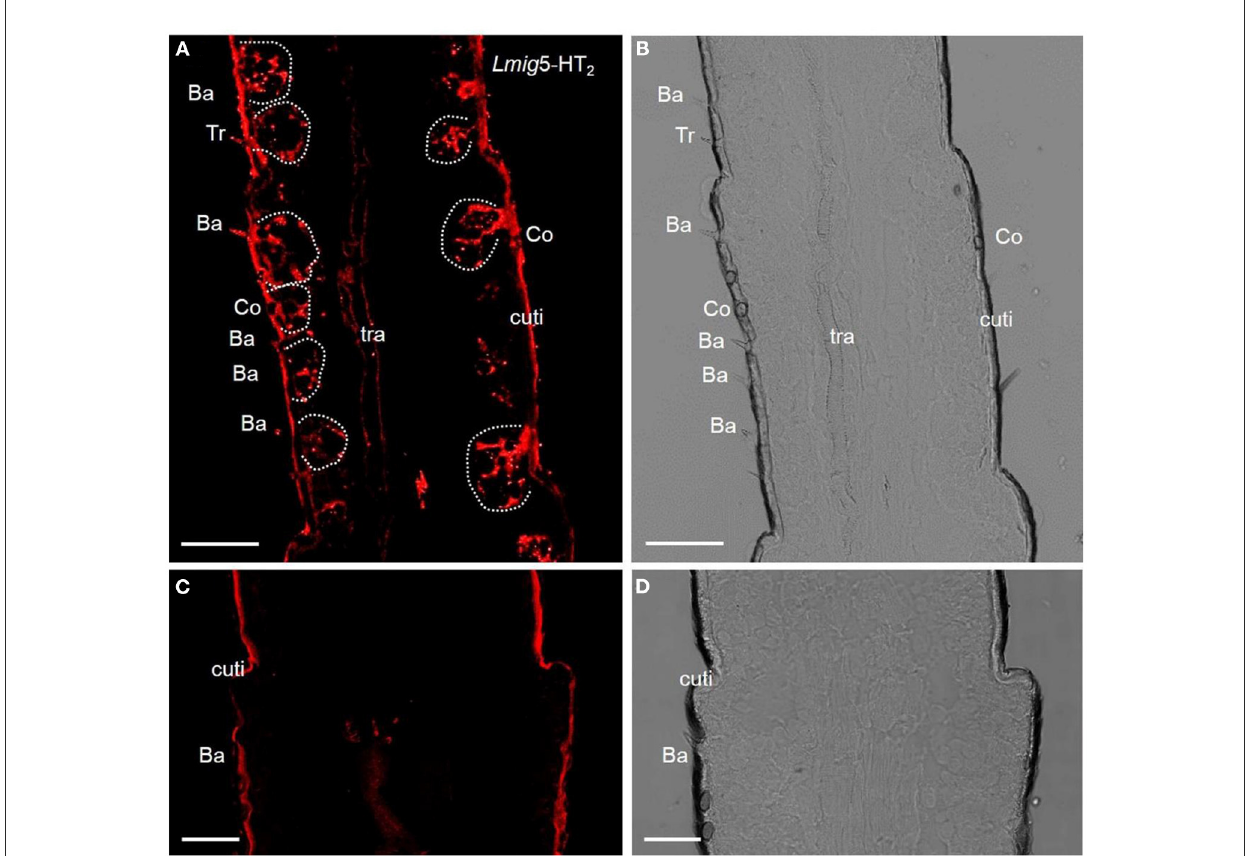
FIGURE2 5-HT receptors in locust antennae. (A) Single-color fluorescence in situ hybridization on the fifth to seventh segments with an antisense probe against Lmig 5-HT 2 RNA with DIG, red. (B) Blank control. Dotted circles indicate cell clusters. (C, D) Negative control without an antisense probe against Lmig 5-HT 2 RNA with DIG, red. Ba, basiconica sensilla; Tr, trichoid sensilla; cuti, cuticle. Scale bar: 100 µ